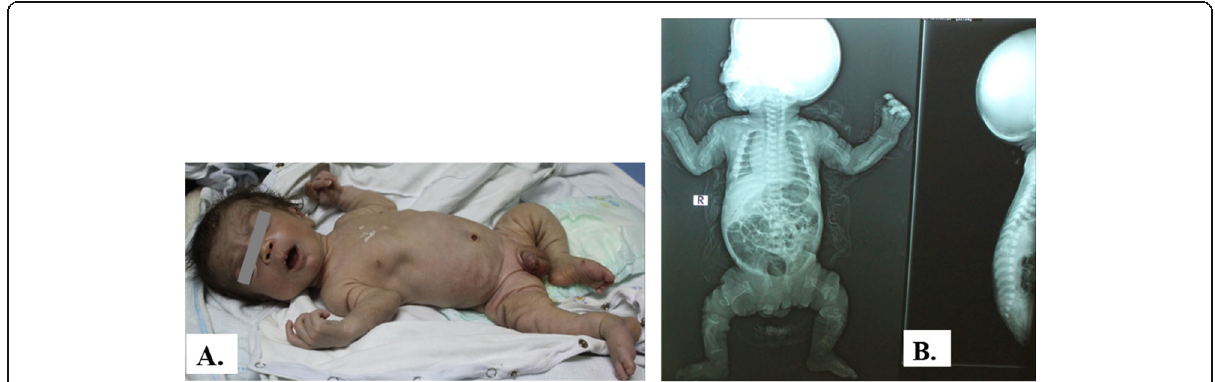
Fig. 2 Patient no. 2 at the age of 3 months. A Coarse facies, digital contractures, indrawn chest wall, and Michelin tyre appearance of skin folds in the limbs. B X-rays showing short thick long bones with splayed metaphyses, small epiphyses, horizontal ribs and short, square or biconvex vertebral bodies